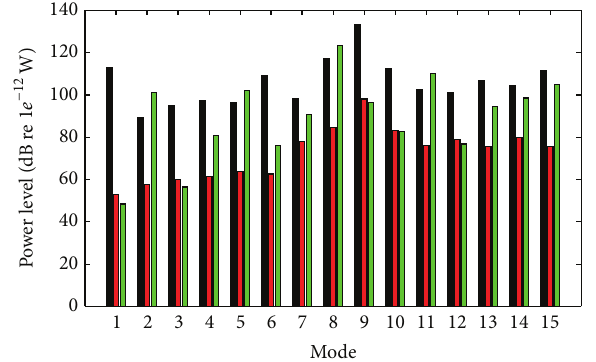
Figure 7: Simulated control sound power levels at the structural modenaturalfrequencies.Theleftcolumnistheradiatedsoundlevel without control, the middle column represents the radiated sound level with control from WSSG, and the right column represents the radiated sound level with control from volume velocity.